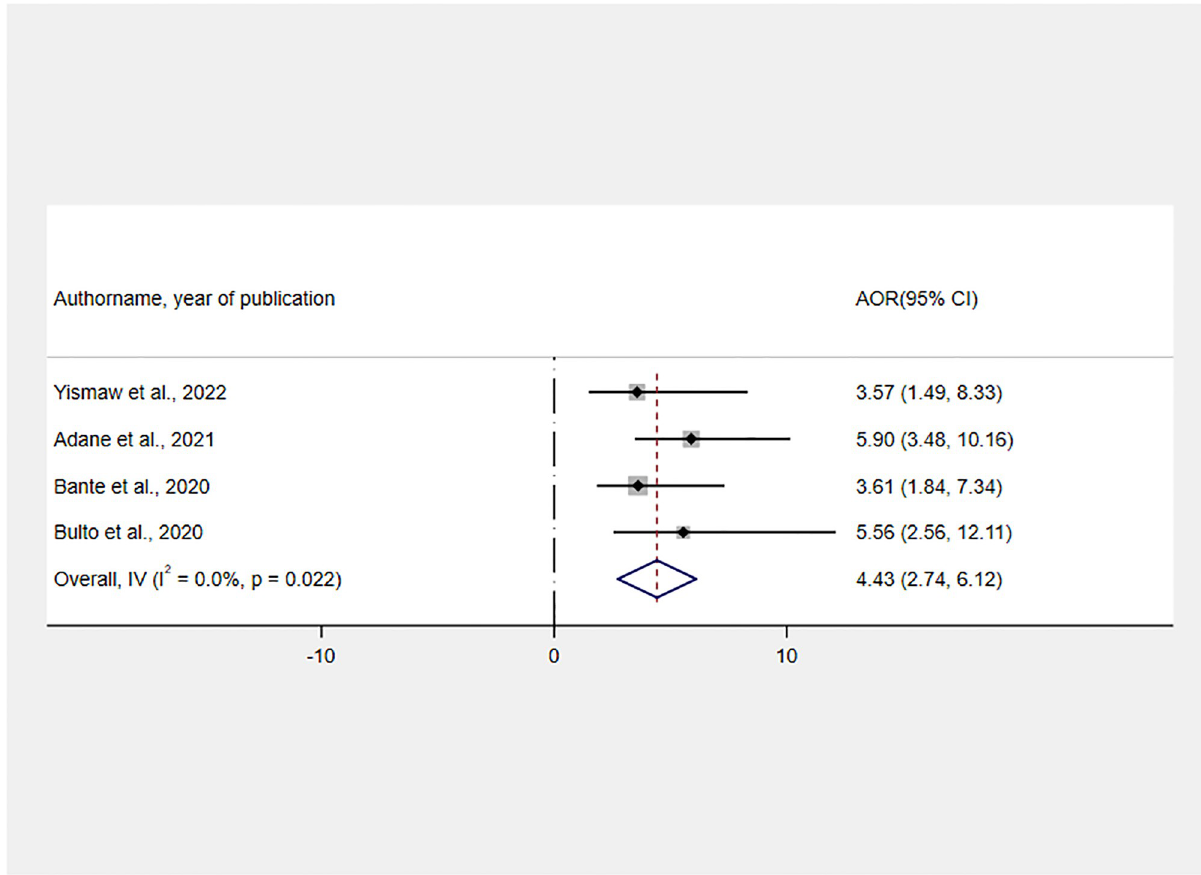
Fig 10. Forest plot showing the association between planned pregnancy and RMC in Ethiopia,